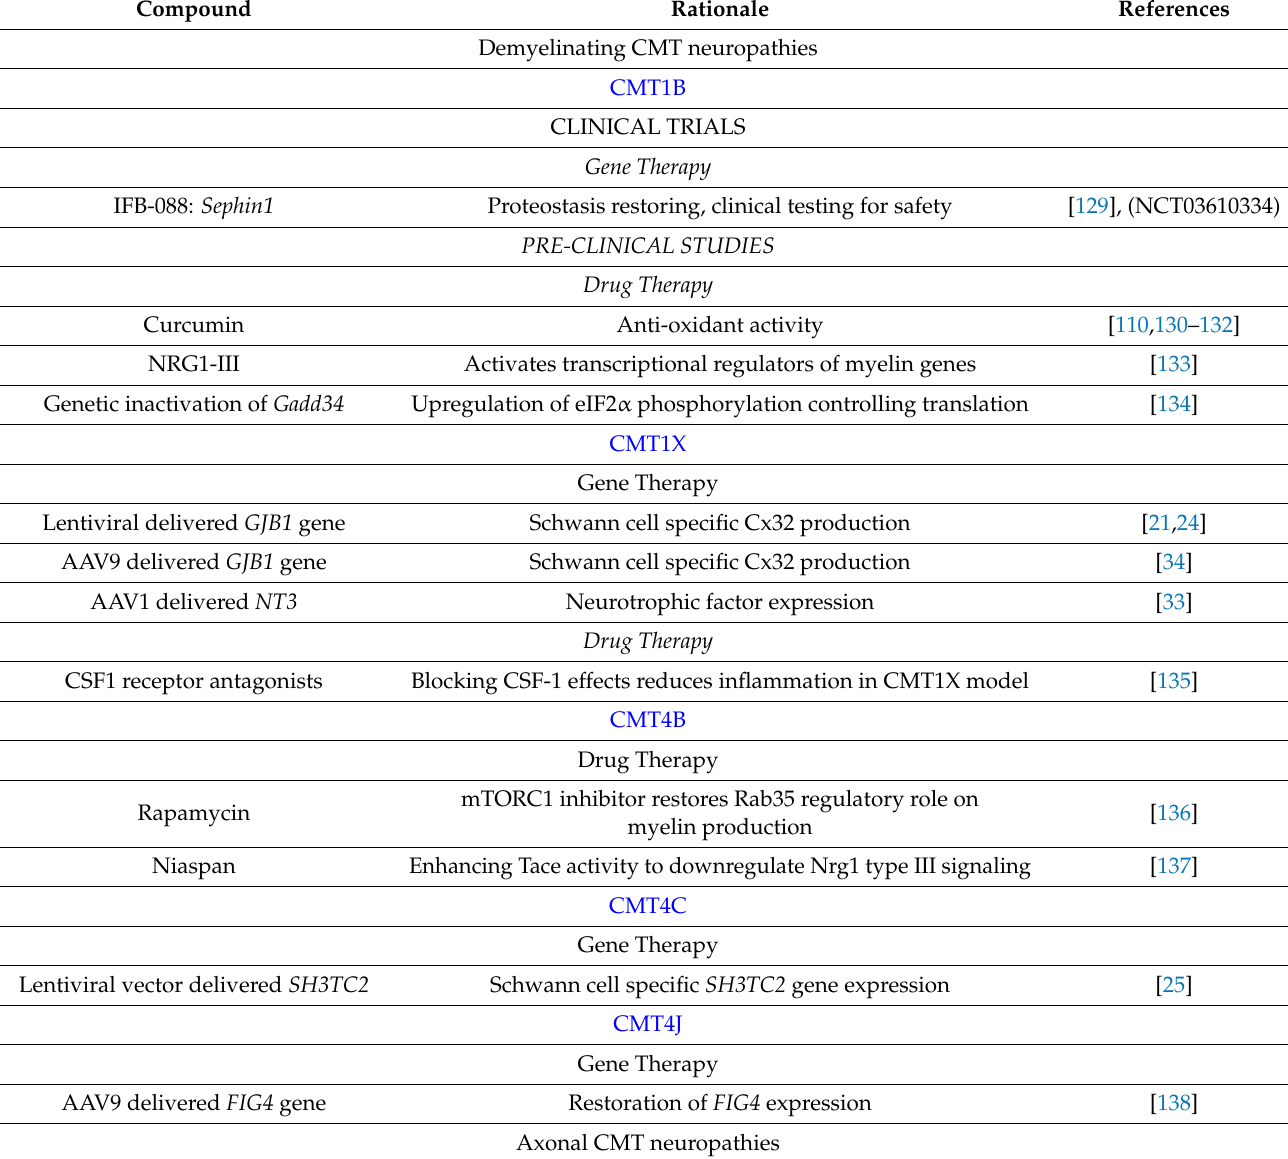
Table 2. Summary of emerging treatment approaches for other CMT